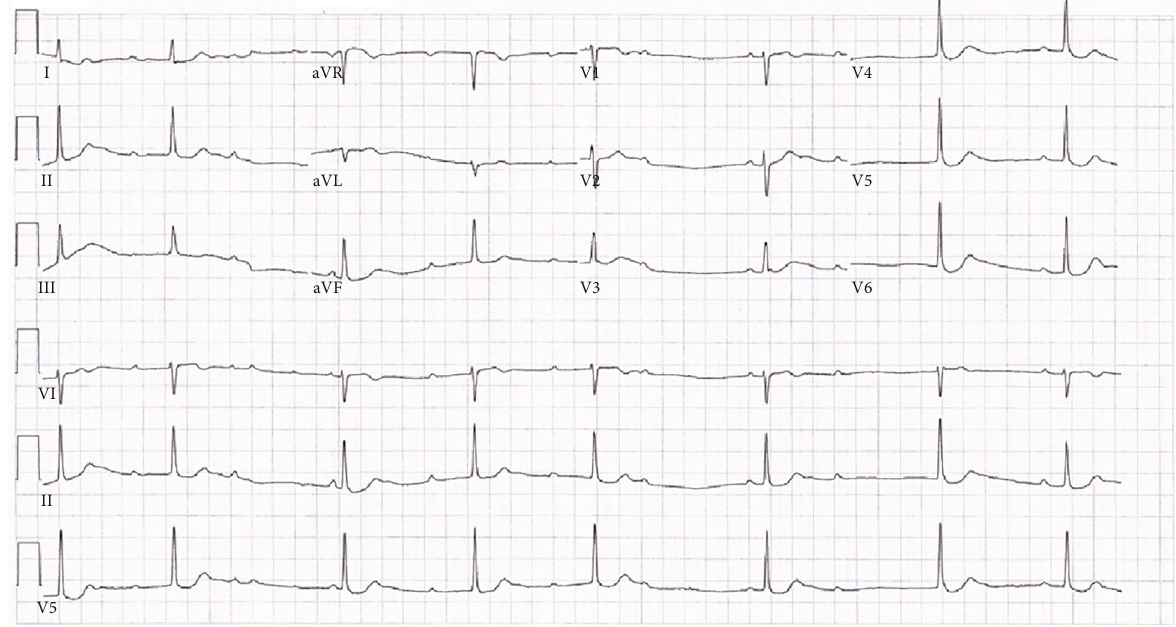
Figure 2: An electrocardiogram showing third-degree atrioventricular heart block three days following ingestion of a